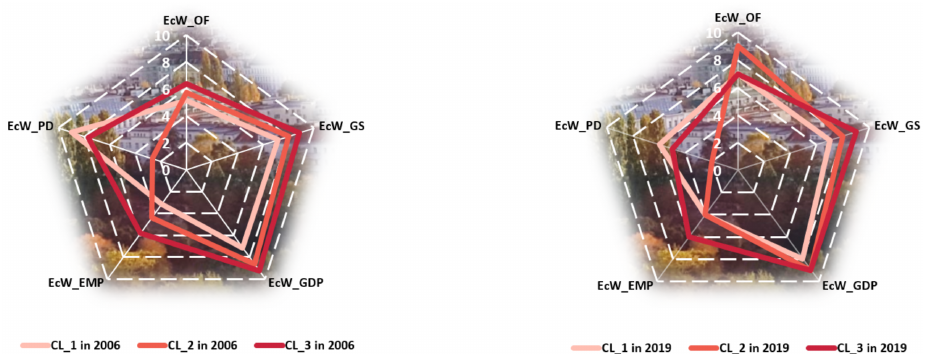
Figure 5. Comparison between clusters regarding economic wellbeing components in 2006 vs. 2019. Source: SSI database, computed in Microsoft Excel